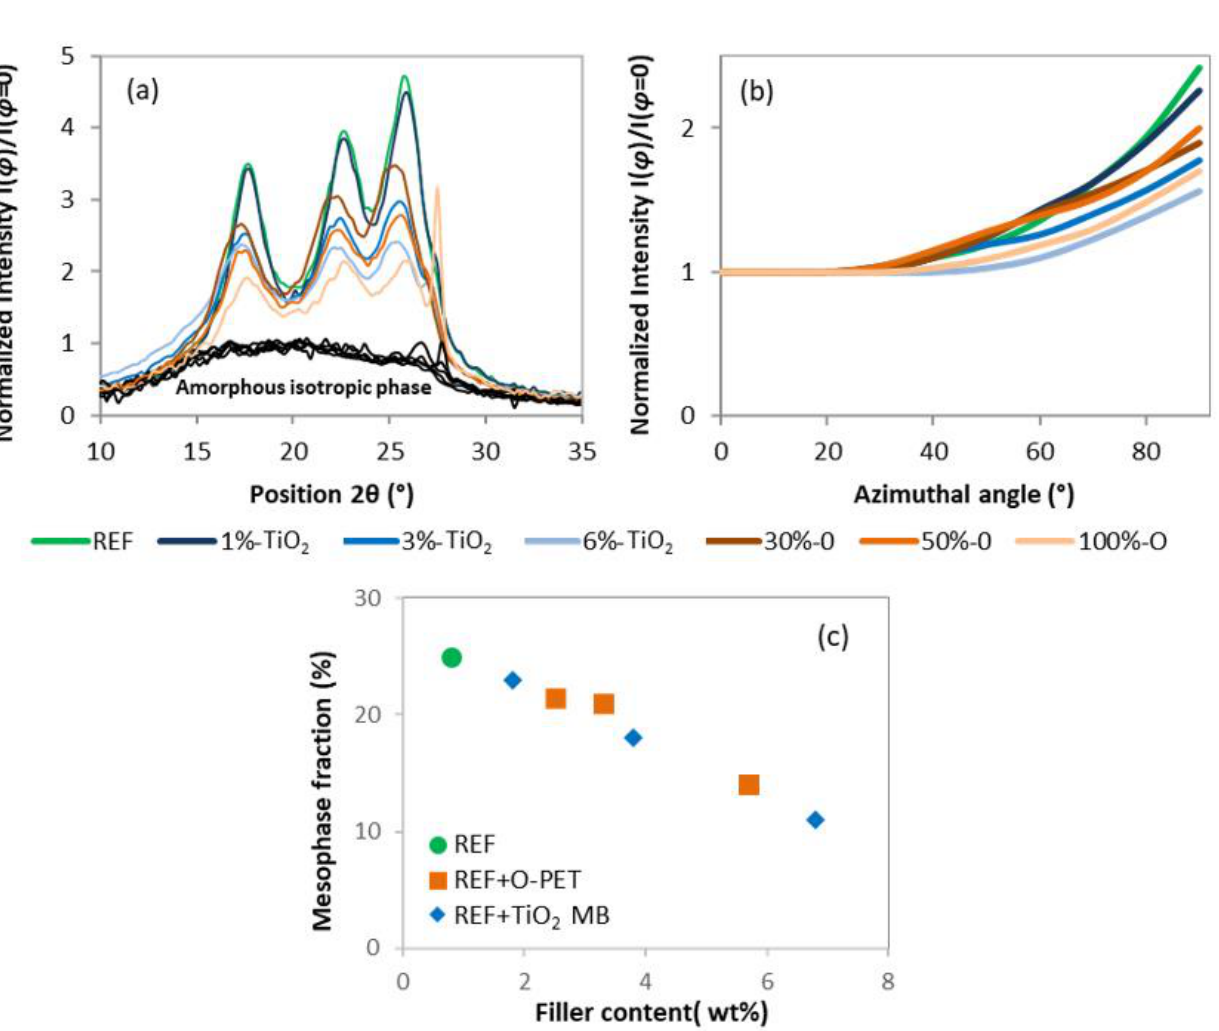
Figure 7. ( a ) Relative X-ray Intensity of the scans at 𝛷 = 90° from 10° to 35° normalized to the inten- sity of the scan at 𝛷 = 0° (black curves) corresponding to the amorphous isotropic phase; ( b ) Inten- sity of X-ray amorphous halo versus azimuthal angle, normalized to the intensity at 𝛷 = 0° ; ( c ) Mesophase fraction (%) versus filler content (wt %).